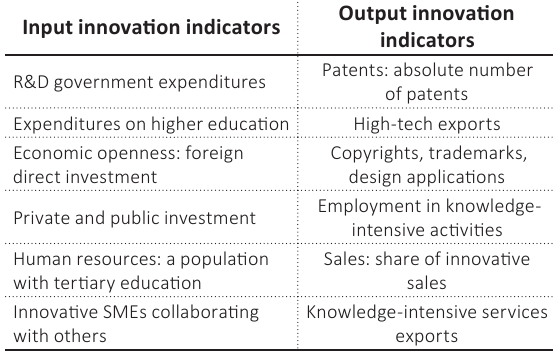
Table 1. Overview of the most